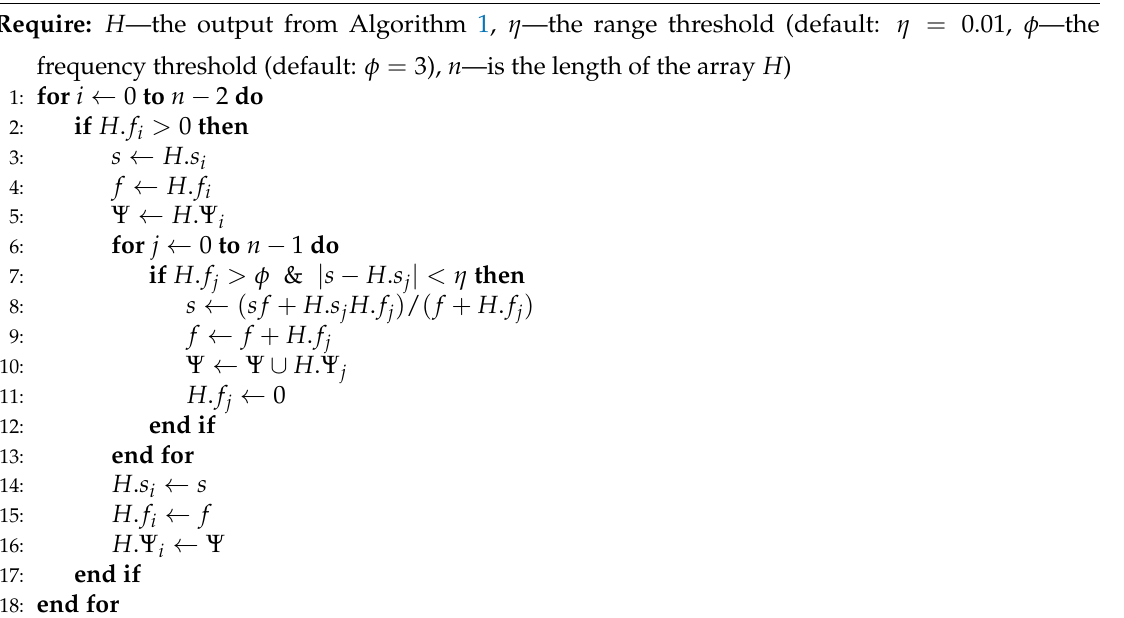
Figure 5. A new s k with frequency f k = f i + f j is obtained from s i and s j ; scaled factors marked with red colour are discarded. Algorithm 2 Scale Factor Discarding And